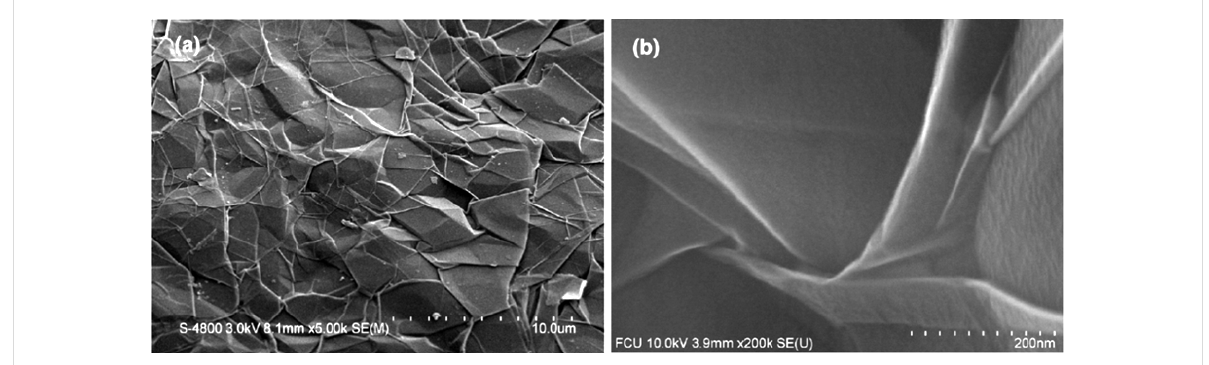
Figure 2: Wrinkling of multilayered graphene: (a) A typical wrinkling pattern. (b) A magnified view of the wrinkles. Reproduced from [16], copyright 2013 Elsevier.